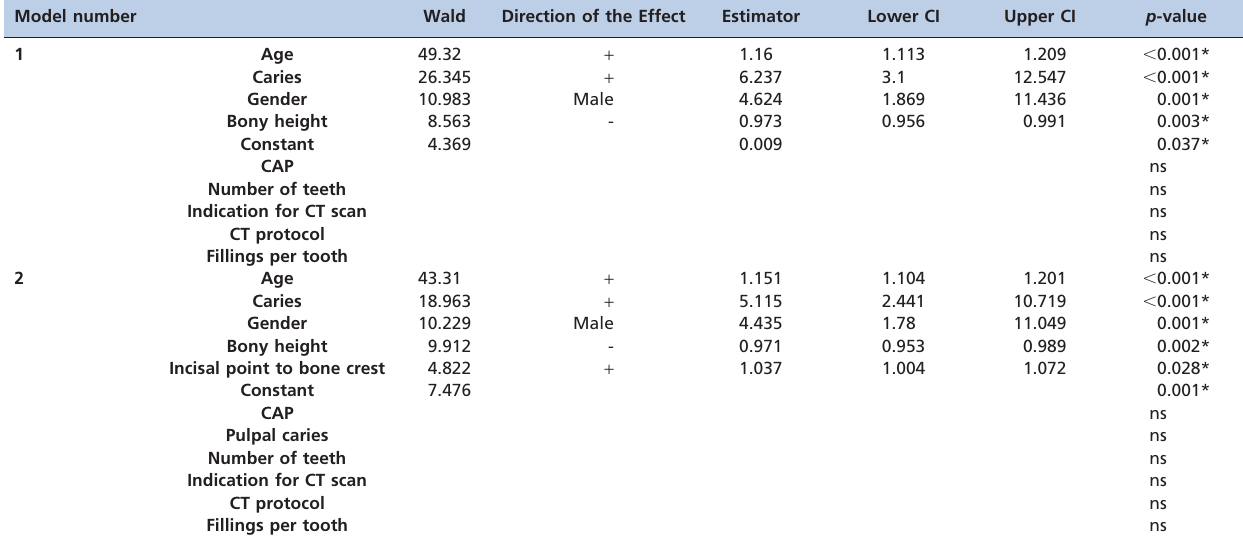
Table 1 - Logistic regression analyses of the target variable ‘‘presence of aortic atherosclerosis’’. First model: Superficial caries and pulpal caries are grouped together as one parameter. Second model: Superficial caries and pulpal caries are separated parameters. N= 248 (both models), Nagelkerke’s R 2 =0.677 (first model) and 0.644 (second model). Pulpal caries appears in the models only if superficial caries is removed (model not shown).